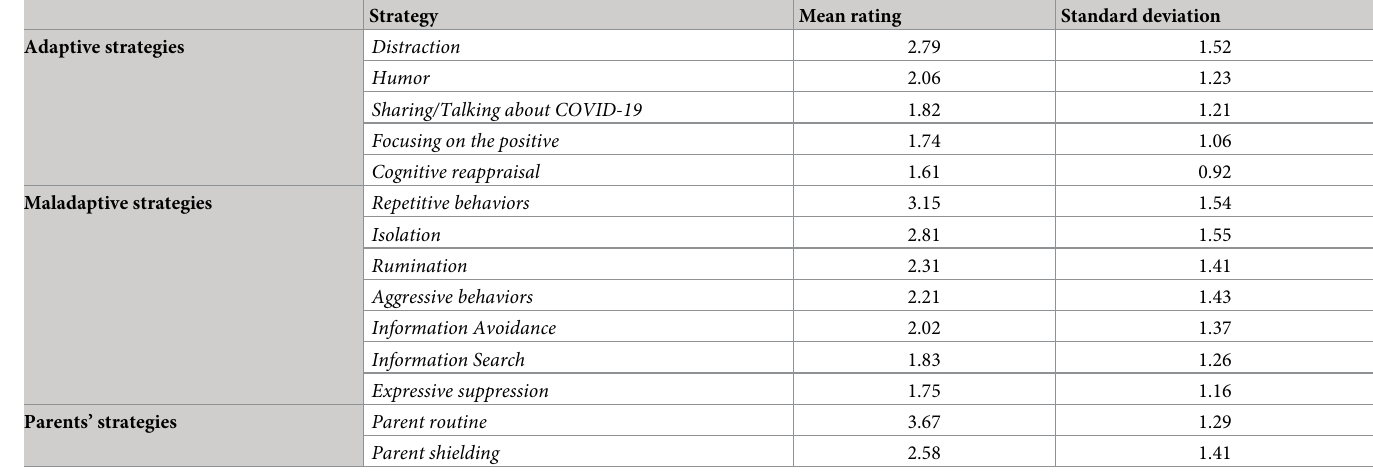
Table 3. Descriptive statistics of the frequency of coping strategies (n = 104).